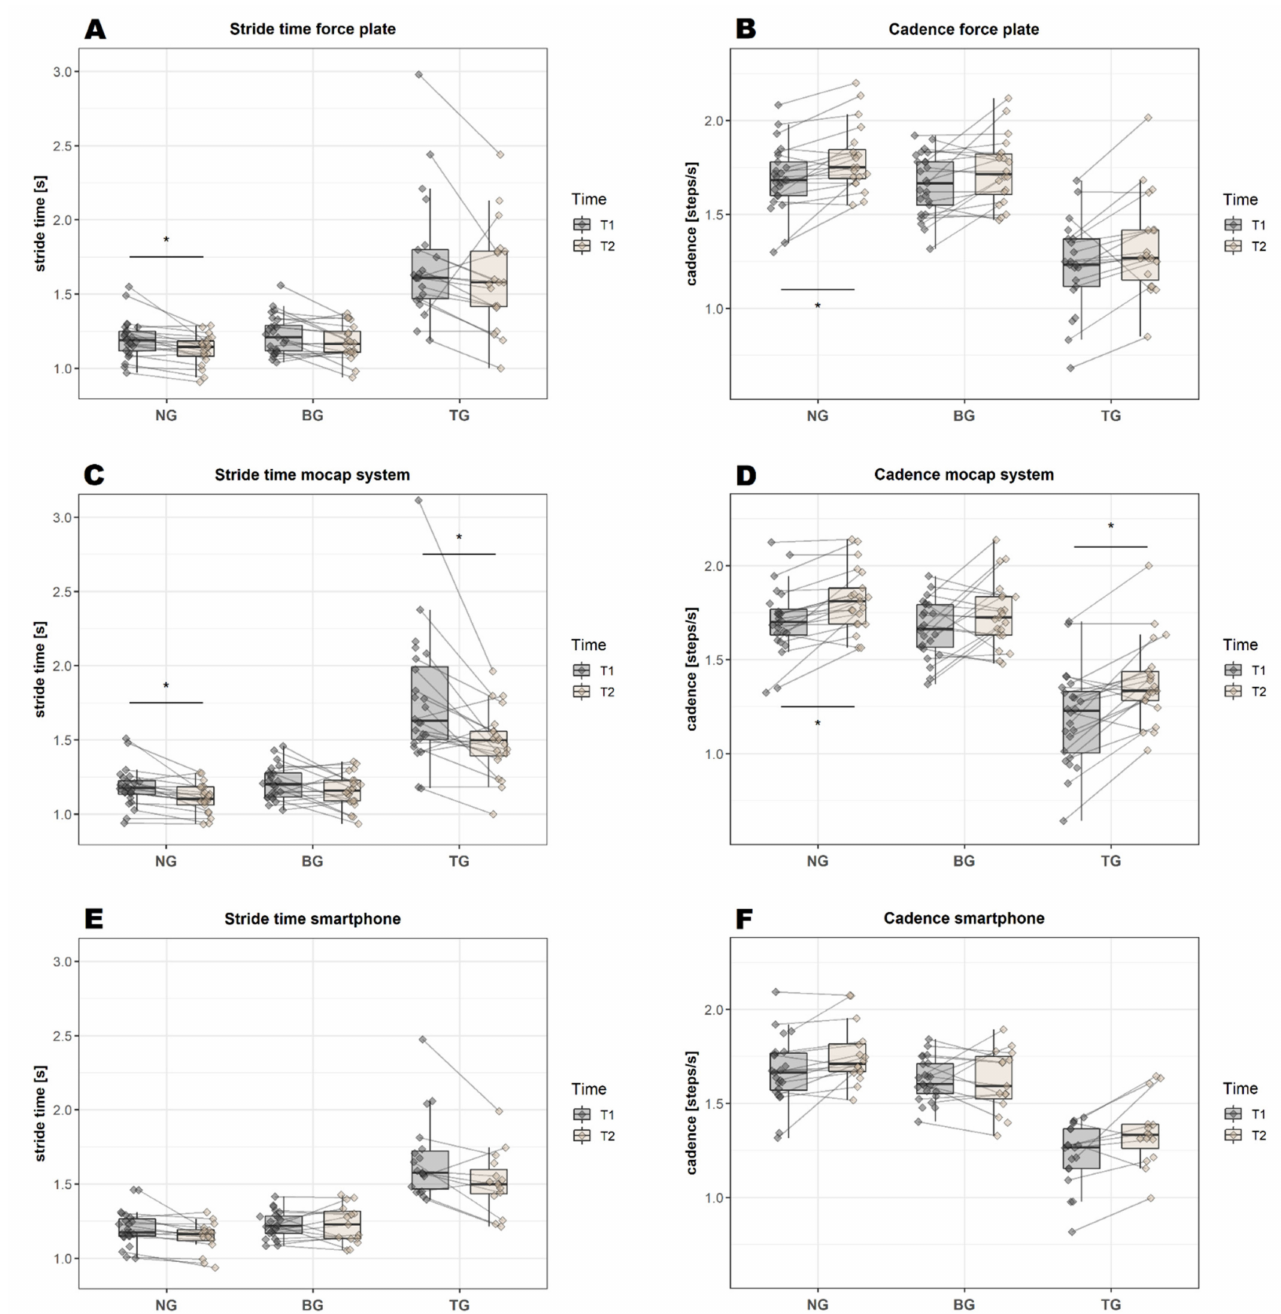
Figure 3. Graphical representation of the mean values of stride time and cadence for all three gait analysis systems at T1 and T2 (before and after training). Significant differences over time (after Bonferroni correction) are highlighted by an asterisk. BG = backward gait, NG = normal gait, TG = tandem